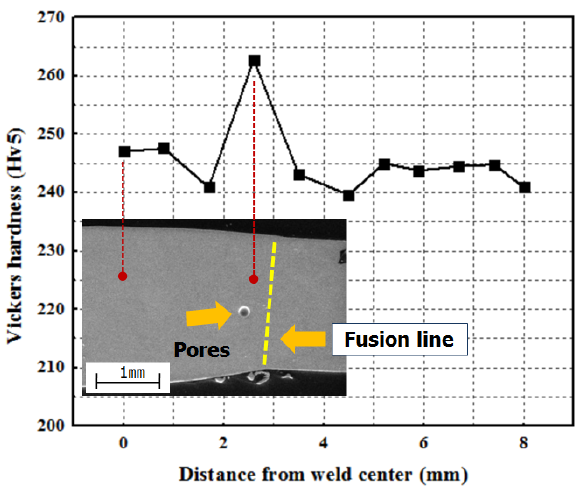
Figure 15. Hardness distribution of titanium weldment (WO).